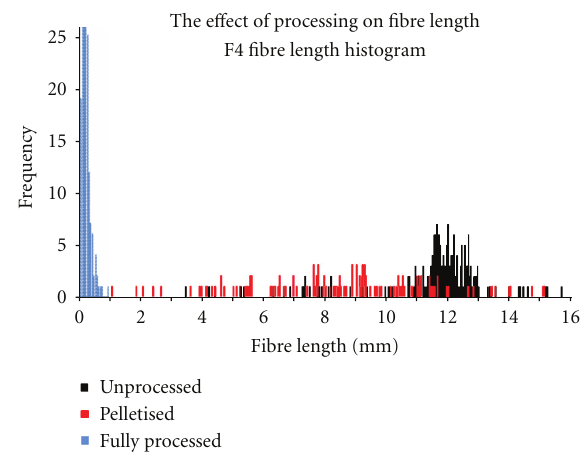
Figure 1: Histograms of fiber lengths of unprocessed, pelletised, and fully processed flax fibers up to 16mm. Frequencies of the fully processed fibers outside y -scale are 81 (0.05 < x ≤ 0.10mm), 83 (0.10 < x ≤ 0.15 mm), and 42 (0.15 < x ≤